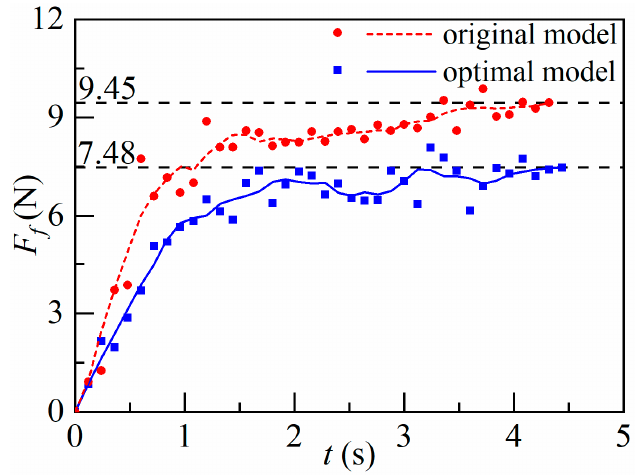
Figure 11. Comparison of sampling resistance between optimal model and original model.